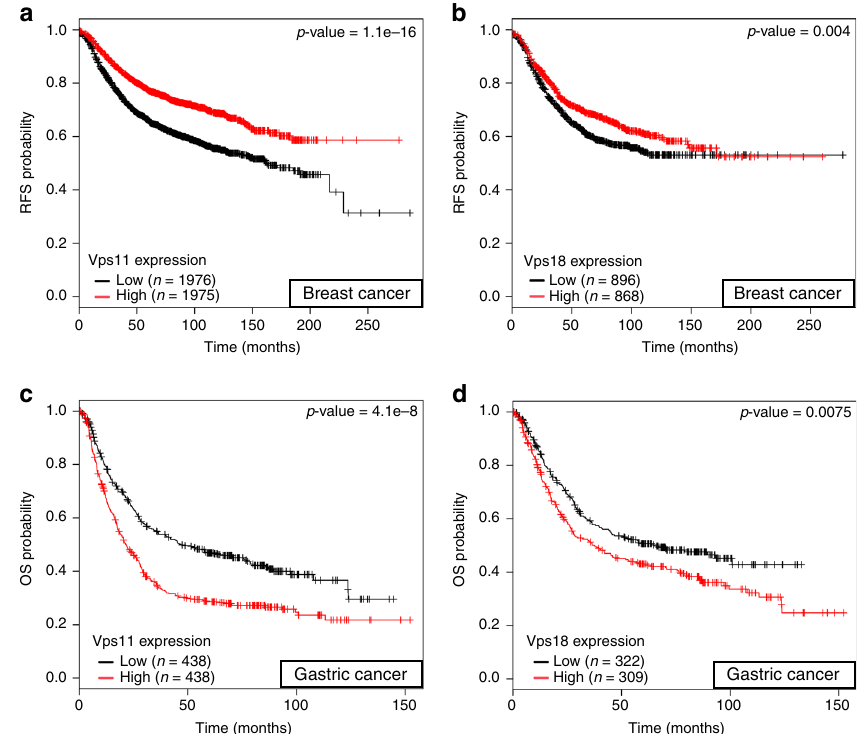
Fig. 7 Vps11/18 de fi ne a cancer type-speci fi c clinical outcome. a – d Kaplan – Meier survival analyses of different cancer types as a function of gene expression levels of Vps11 ( a , c ) or Vps18 ( b , d ). a , b Relapse-free survival (RFS) analyses of patients with breast tumors. c , d Overall survival (OS) analyses of patients with gastric tumors